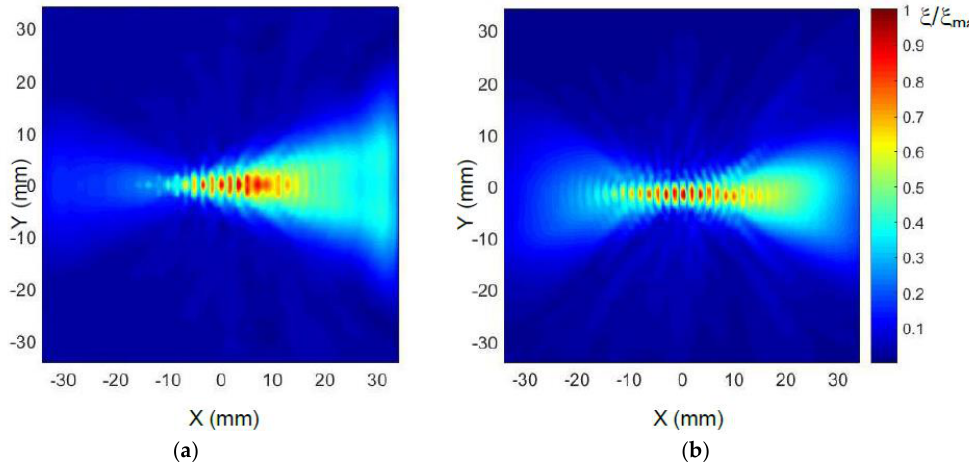
Figure 20. 2D spatial distribution of normal displacements ξ of the plastic film after 3D filtering: ( a ) calculated; and ( b ) measured. The presented amplitude values shown in the color bar were normalized with respect to the maximum value in the field.